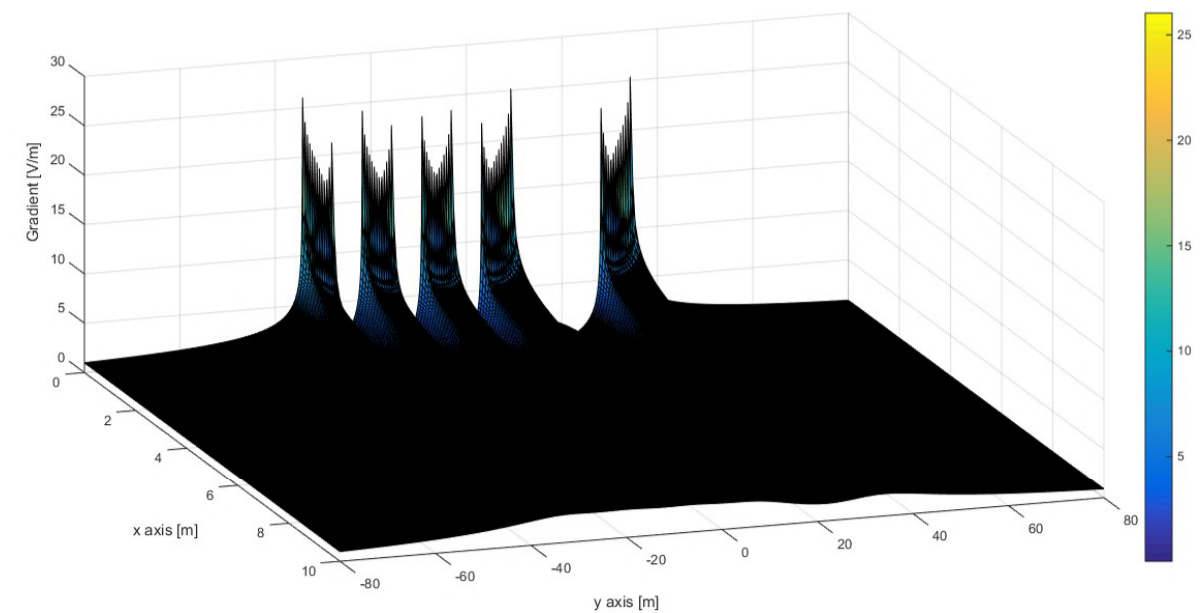
Figure 24. Electric field strength for method “C”, of linear current source, for an electrode station of 6 linear frames in a row with d frames = 6.50 m; each frame consists of 13 electrodes of active length L = 2.13 m, D el = 0.50 m, ρ w = 0.25 Ω · m, θ = 248 ◦ (area of Korakia), J full_load_steady = 22 A/m 2 (steady state and operation of 5 frames, except no.